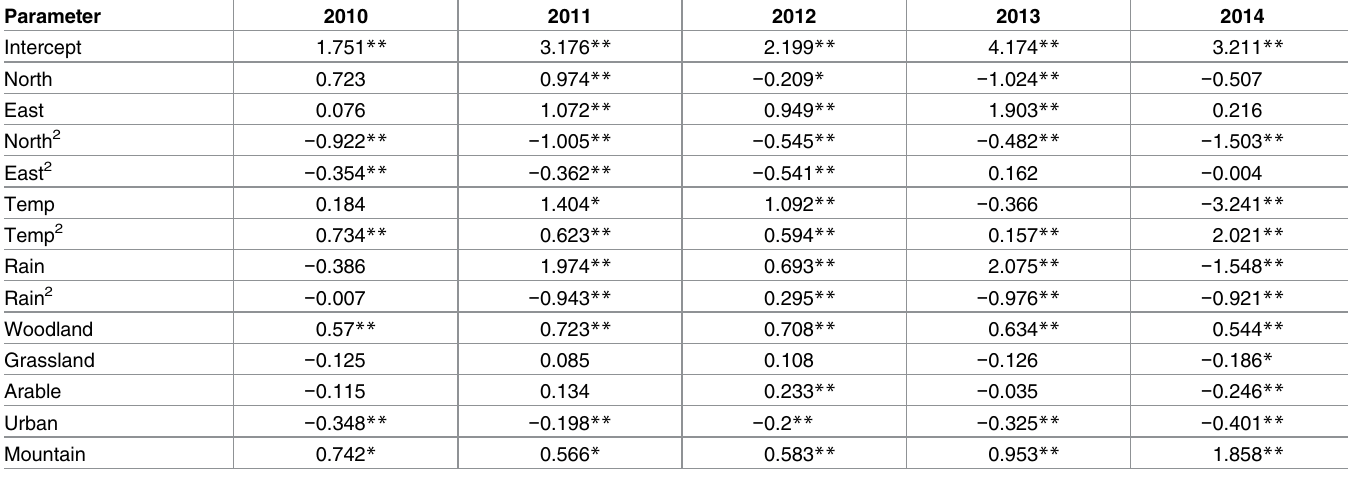
Table 2. Estimated covariatecoefficients for occupancy for Large